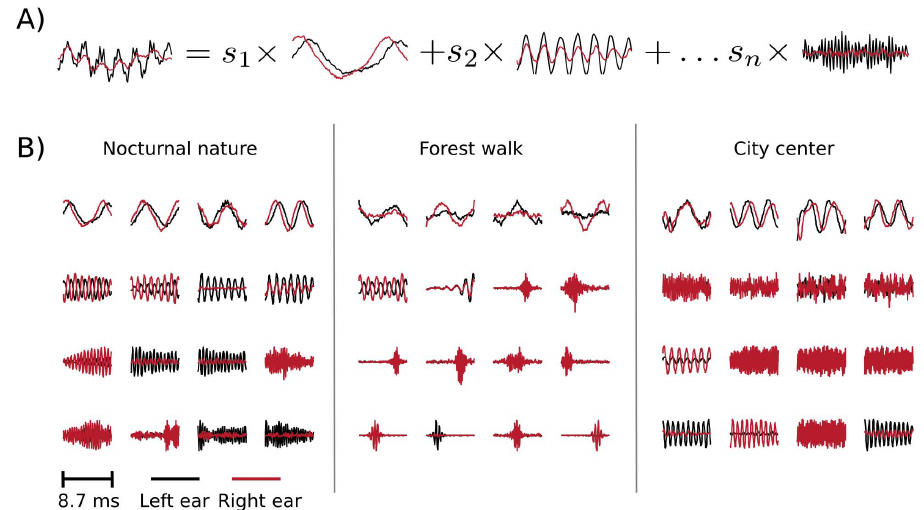
Figure 9. Independent components of natural binaural sounds. A) An explanation of the ICA model. Each epoch of binaural sound (left hand side of the equation) is represented by a linear combination of basis functions (or independent components). Coefficients s i are assumed to be sparse and their joint distribution is equal to the product of marginals. B) Exemplary ICA basis functions from each recorded scene. Nocturnal nature and city center scenes consisted mostly of harmonic sounds and are mostly represented by ICs resembling Fourier bases. The forest walk scene included multiple transient sounds, which gave rise to wavelet-like features.